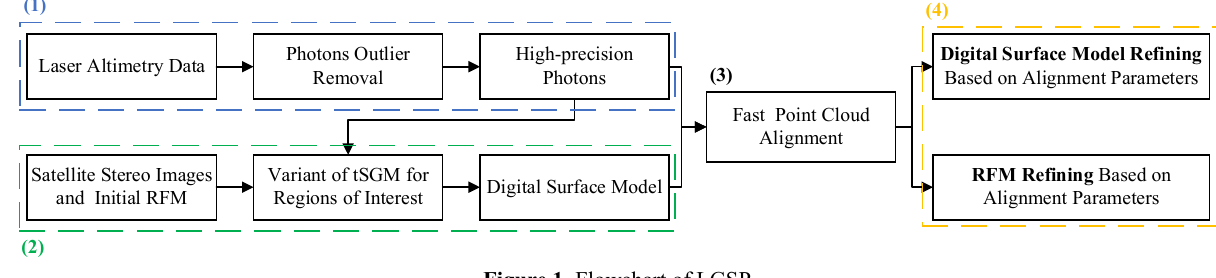
Figure 1. Flowchart of